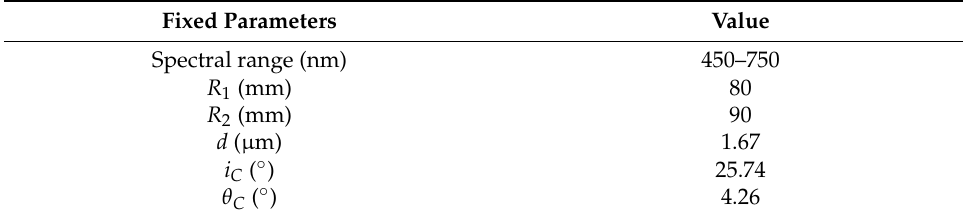
Table 2. Fixed parameters of the optical system.